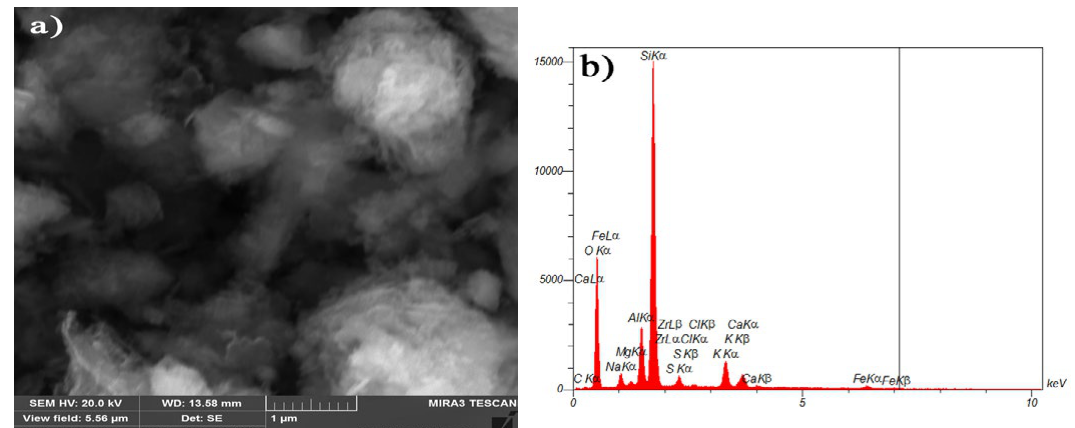
Figure 2: Scanning electron microscopy (SEM) image (a) and EDX analysis (b) of nanozeolite Fig. 2. Scanning electron microscopy (SEM) image (a) and EDX analysis (b) of